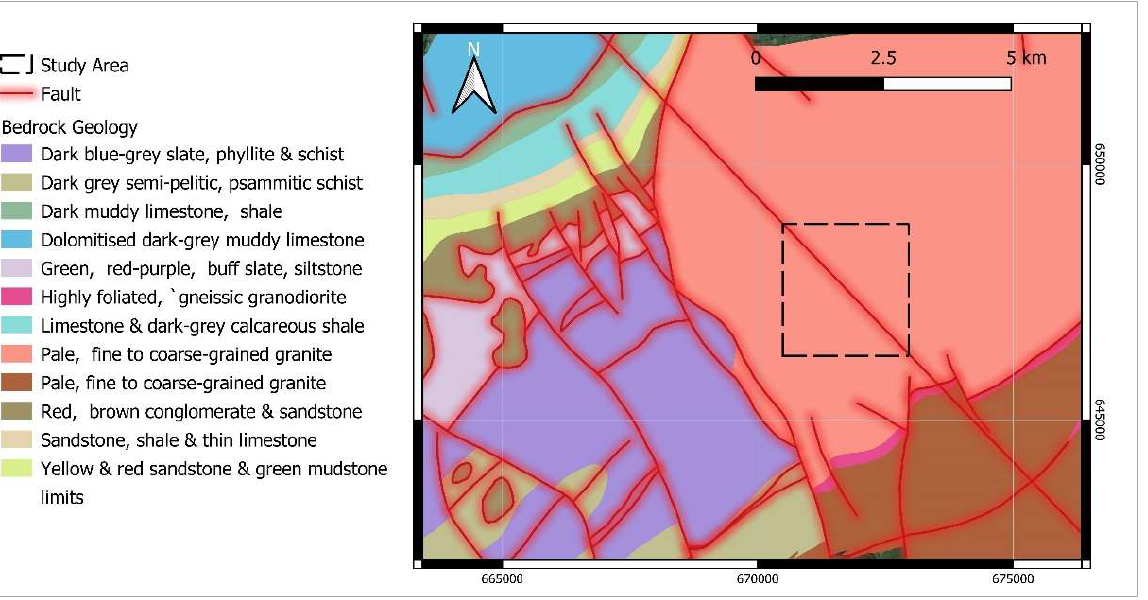
Figure 2. Geological map of the study area, extrapolated from Bedrock Geology map (scale 1:100,000) of Geological Survey Ireland (GSI).